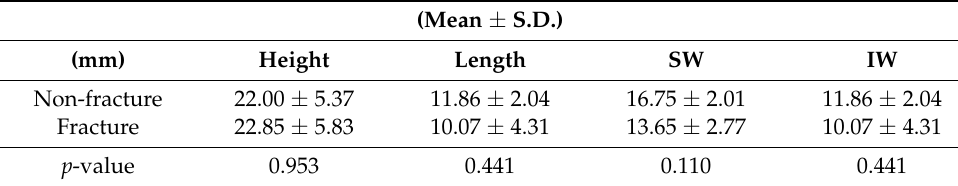
Table 6. Comparisons of measurement on harvested bone segment.